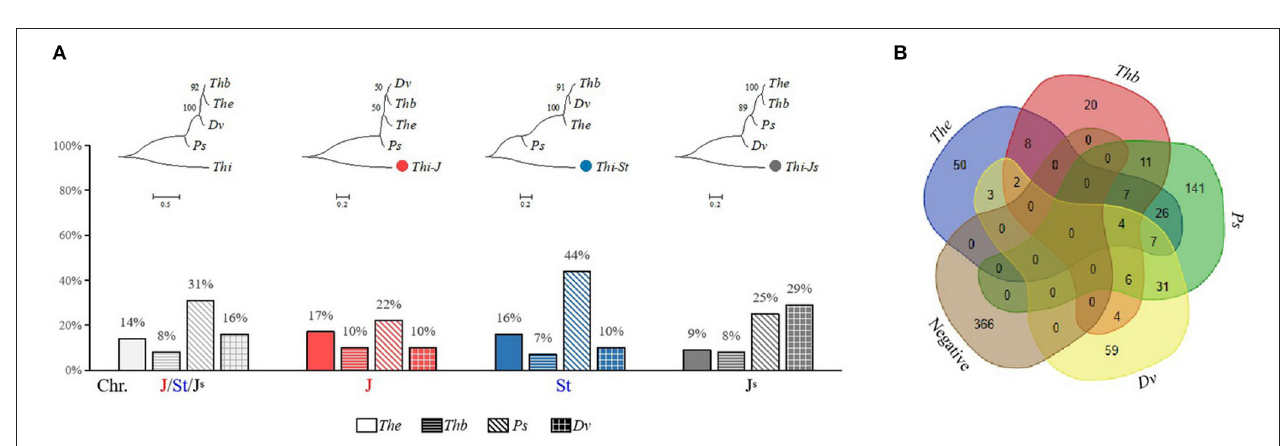
FIGURE 6 | Amplification of Thi -specific markers in the J e /J b /St/V genomes. (A) Phylogenetic analysis and proportion of the positive Thi -specific markers in Th. elongatum ( The ), Th. bessarabicum ( Thb ), Ps. spicata ( Ps ), and D. villosum ( Dv ). (B) Number of the negative and positive Thi -specific markers in Th. elongatum , Th. bessarabicum , Ps. spicata , and D. villosum